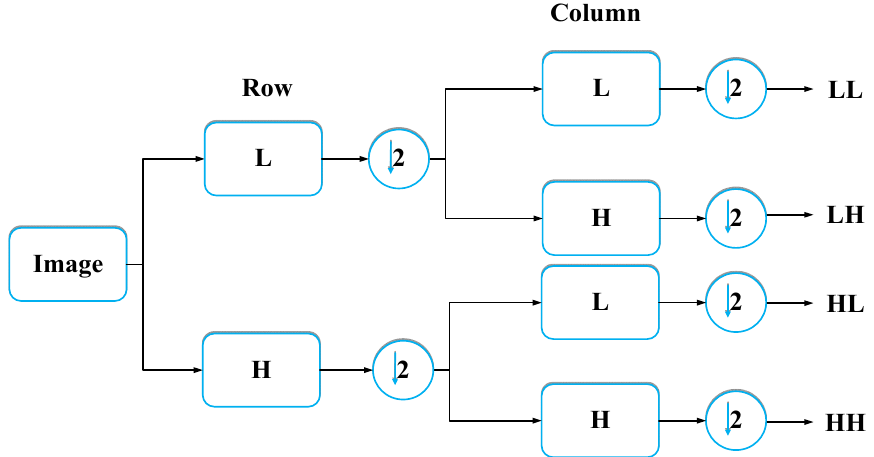
Figure 3. One-level wavelet transform for image.